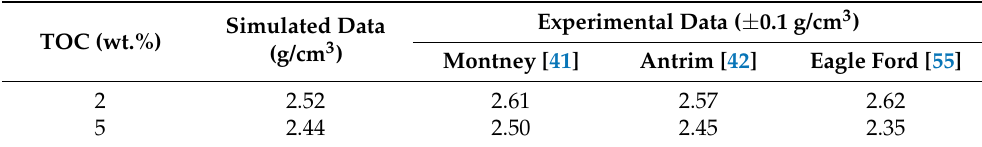
Table 3. Comparison of simulated and experimental densities. TOC